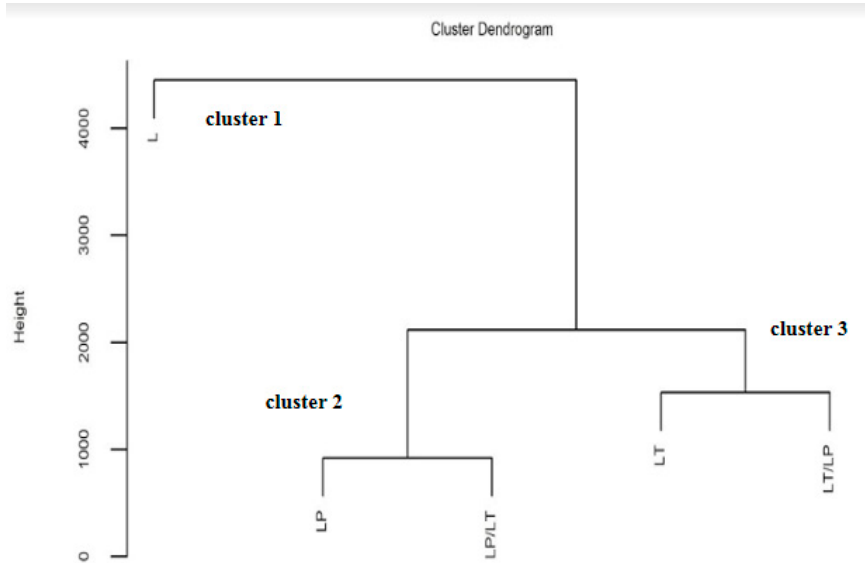
Figure 3. Cluster dendrogram of the four treatment applications based on the residual concentrations of heavy metals and the physicochemical parameters.